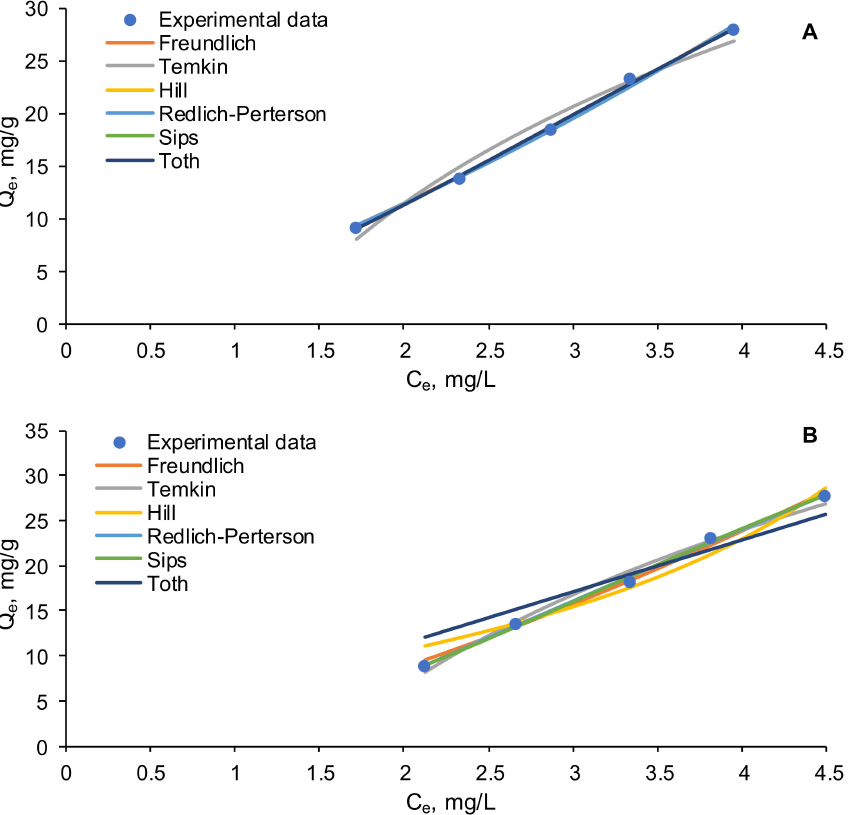
Figure 8. Equilibrium isotherms for the biosorption of EL on synthesized biosorbents (( A )—SPA 5%; ( B )—SPRBA